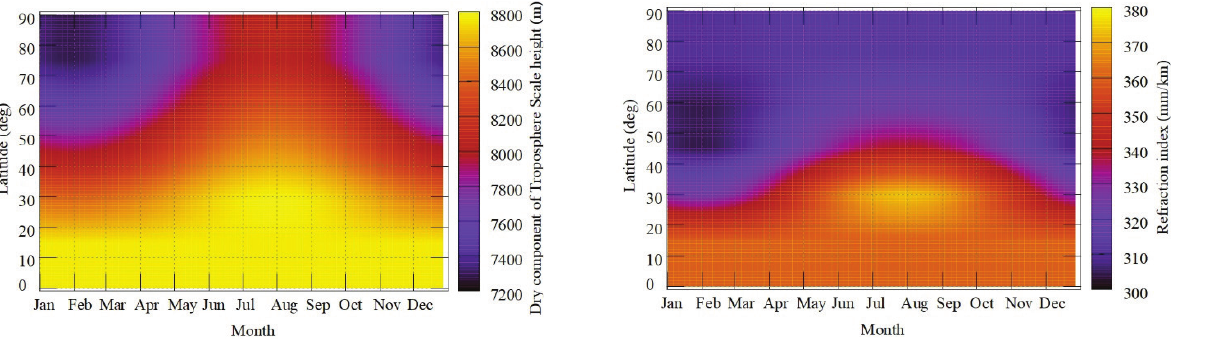
Figure 4. Simulation of the dry component of the troposphere scale height